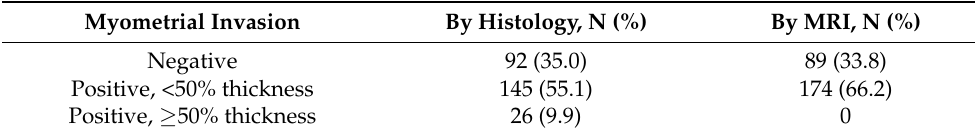
Table 2. The myometrial invasion assessment by MRI and histopathology.